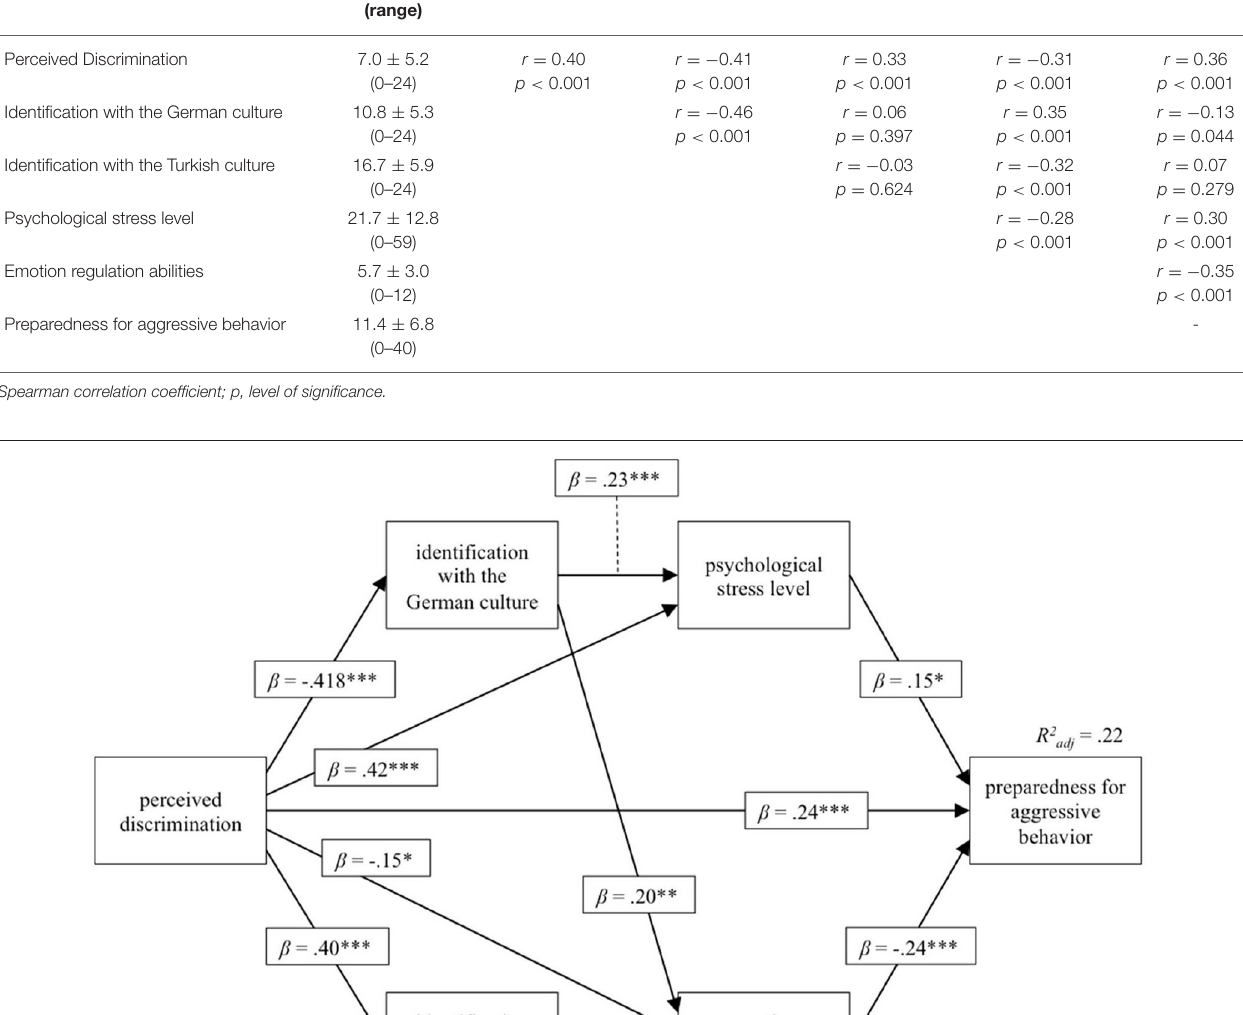
criterion. Based on the interpretation of the scree plot, a one- factor solution was chosen, which resolved 40.7% of the